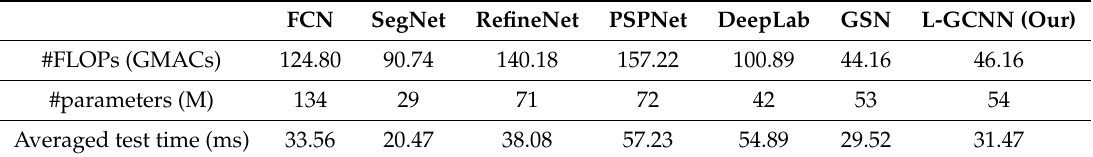
Table 7. Computational complexity, including total number of the FLoating-point OPerations (FLOPs), number of network parameters and average test time for each image of 384 × 384 pixels on a TITAN Xp GPU with 12G